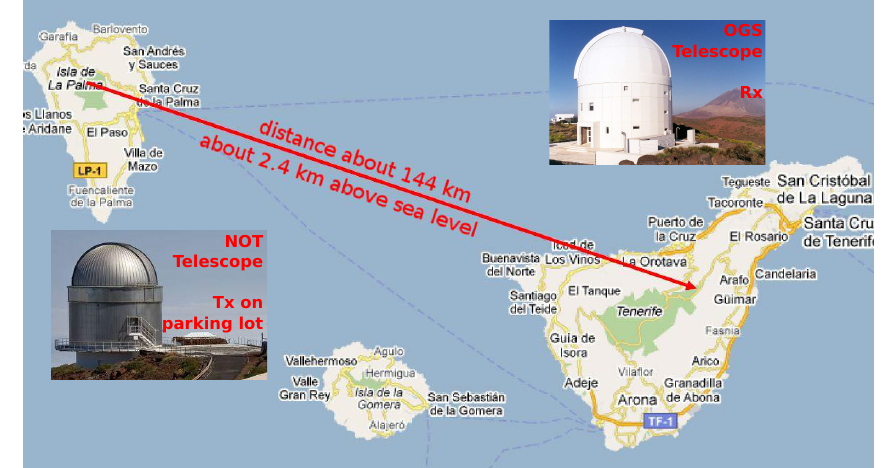
Figure 1. Schematic view of the ∼ 144km long-range infrared-laser link between La Palma (Tx) and Tenerife (Rx) and illustrative pictures of the NOT parking lot location and the OGS